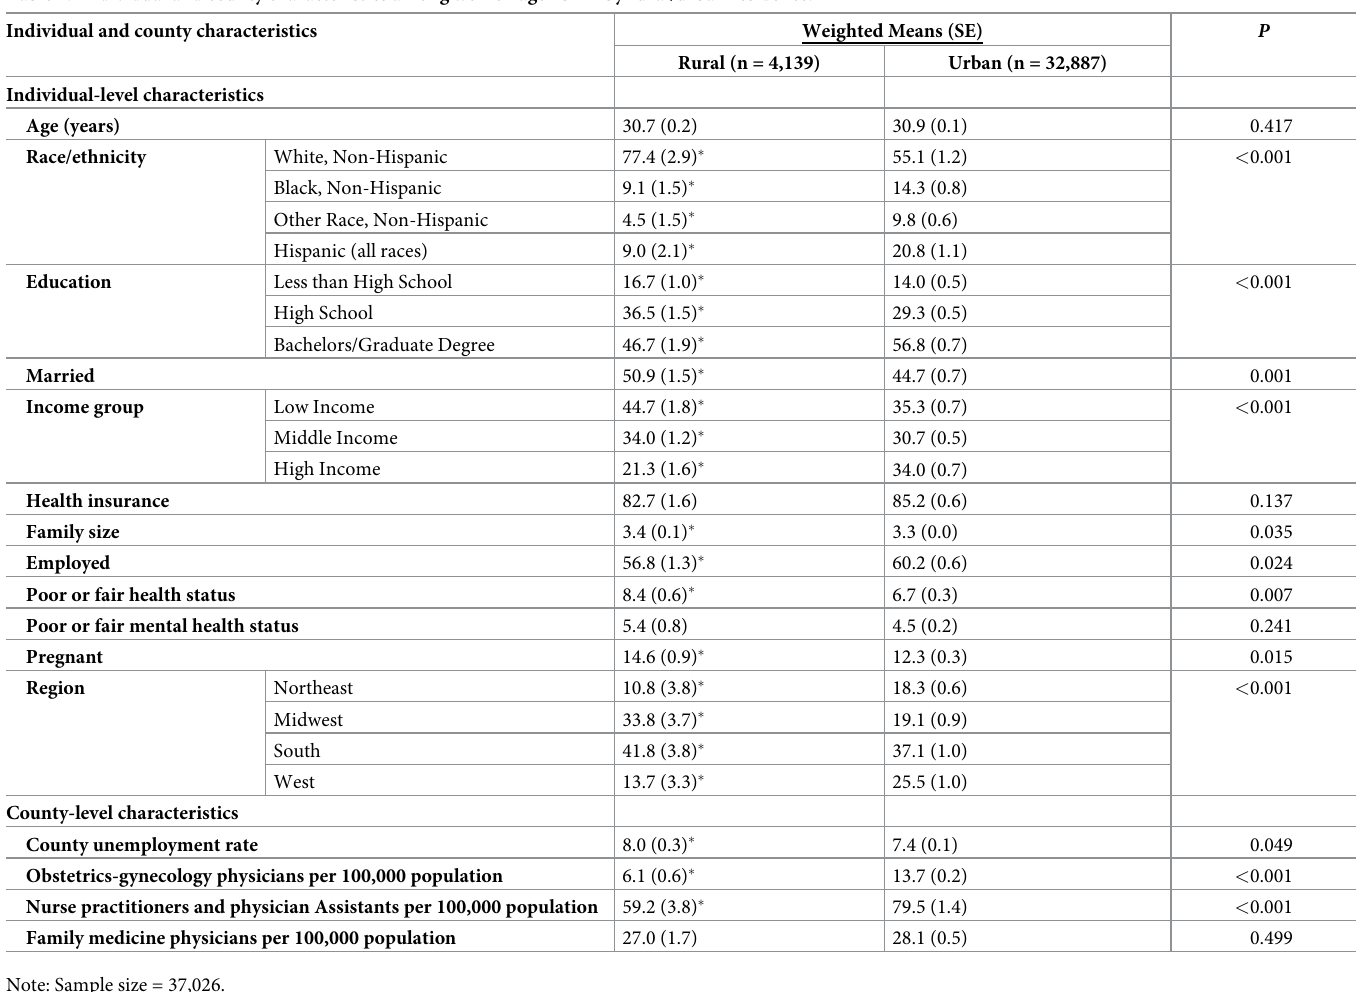
Table 2. Individual and county characteristics among women age 18–44 by rural/urban